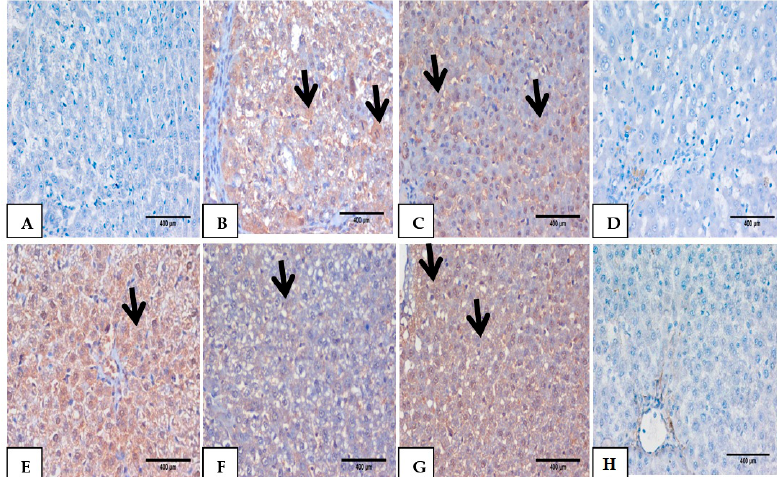
Figure 6. ( A ) Liver section stained with immunohistochemistry for IL6, ( B ) represents TAA +Ve intoxicated control group as it showed a dense expression of IL6 as a brownish cytoplasmic stain of hepatocytes in about 60% (black arrow), ( C , D ) liver sections pretreated with Ms and NMs showed a very light mild density of IL6 as brownish cytoplasmic stain 20%,while NMs group sections showed a pronounced effect with negative expression of IL6 (black arrow), ( E , F ) liver sections from prophylactic (Ms and NMs) showed moderate improvement in brownish cytoplasmic stain IL6 expression 10–50% (black arrow), ( G , H ) Liver sections treated with Ms and NMs show a marked improvement with a very light expression of IL6 10–50% as a brownish cytoplasmic stain (black arrow) (DAB,IHC, × 400). Biomolecules 2020 , 10 , x